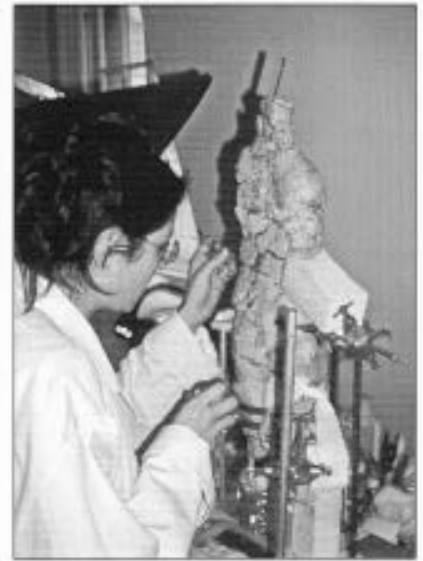
Figure 7 Gap-filling missing areas in the torso of Noah during reassembly and reconstruction on Perspex